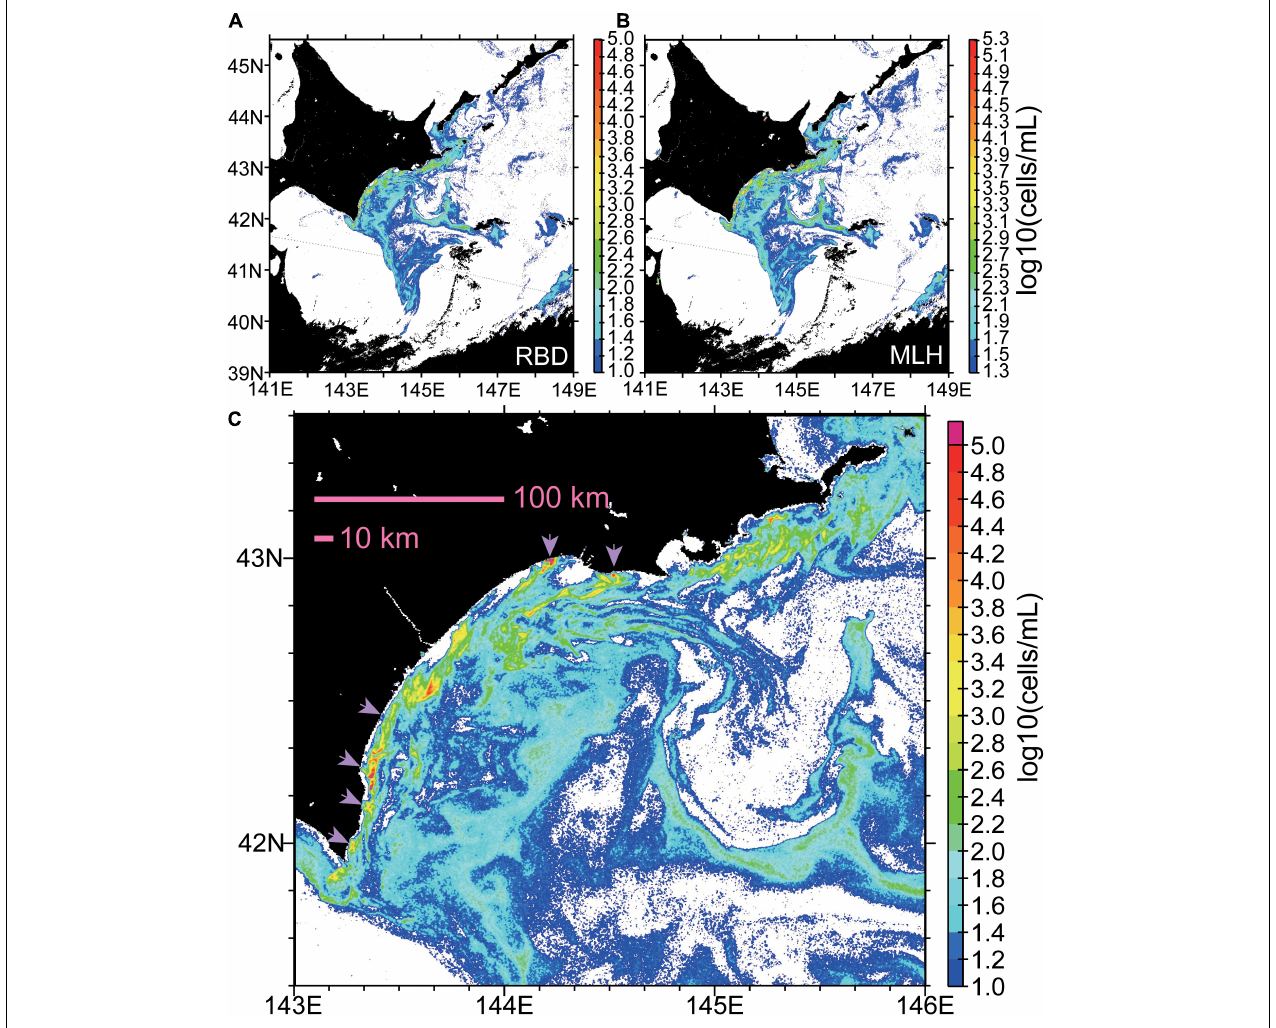
FIGURE 12 | Maps of Karenia abundance (log 10 [cells mL − 1 ]) on 9 October 2021, estimated (A) directly from red-band difference (RBD) or (B) indirectly from maximum line height (MLH) and estimated chlorophyll- a concentrations. The color scale of panel (B) is offset from that of panel (A) by 0.3, which corresponds to about a 2-fold difference [i.e., 10 0 . 3 ∼ 2]. (C) The same as panel (A) , but for a smaller area. Light purple arrows indicate high abundances in very nearshore